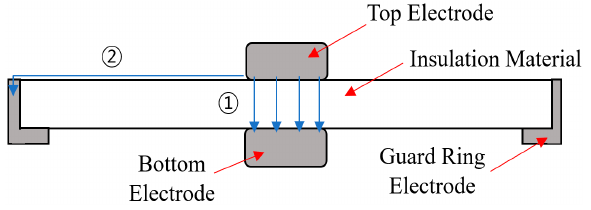
Figure 7. Guard-ring terminal electrode structure for measuring insulator resistivity.